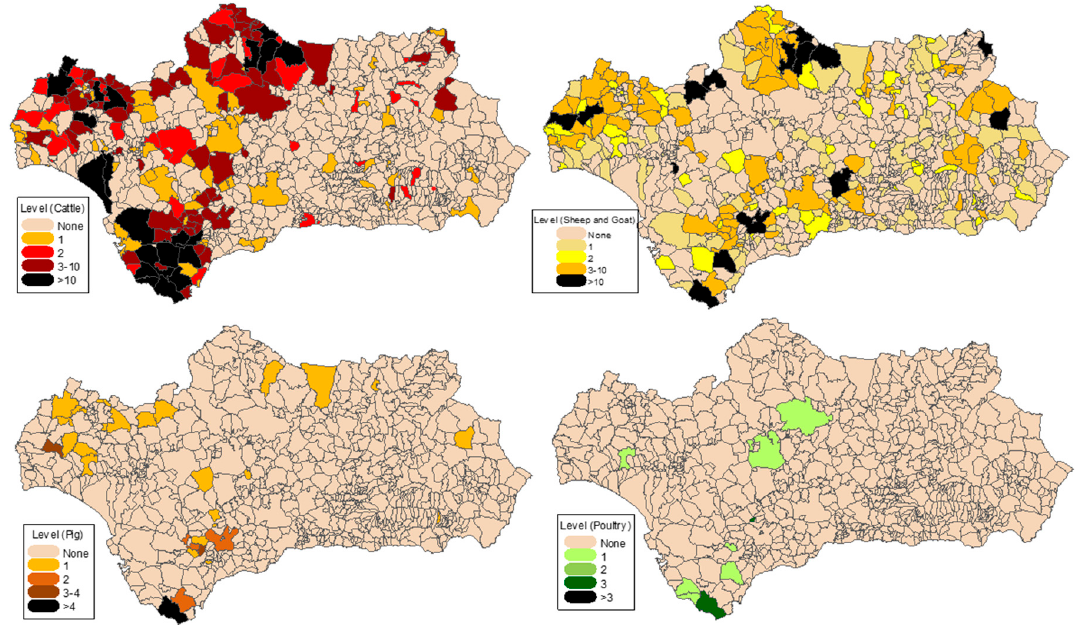
Figure 3. Spatial distribution of total organic livestock farms by municipality and class. This spatial distribution shows how the frequencies of pig and poultry farms are very low (too many zeros); however, this is not the case for the number of cattle farms and for sheep and goat farms.